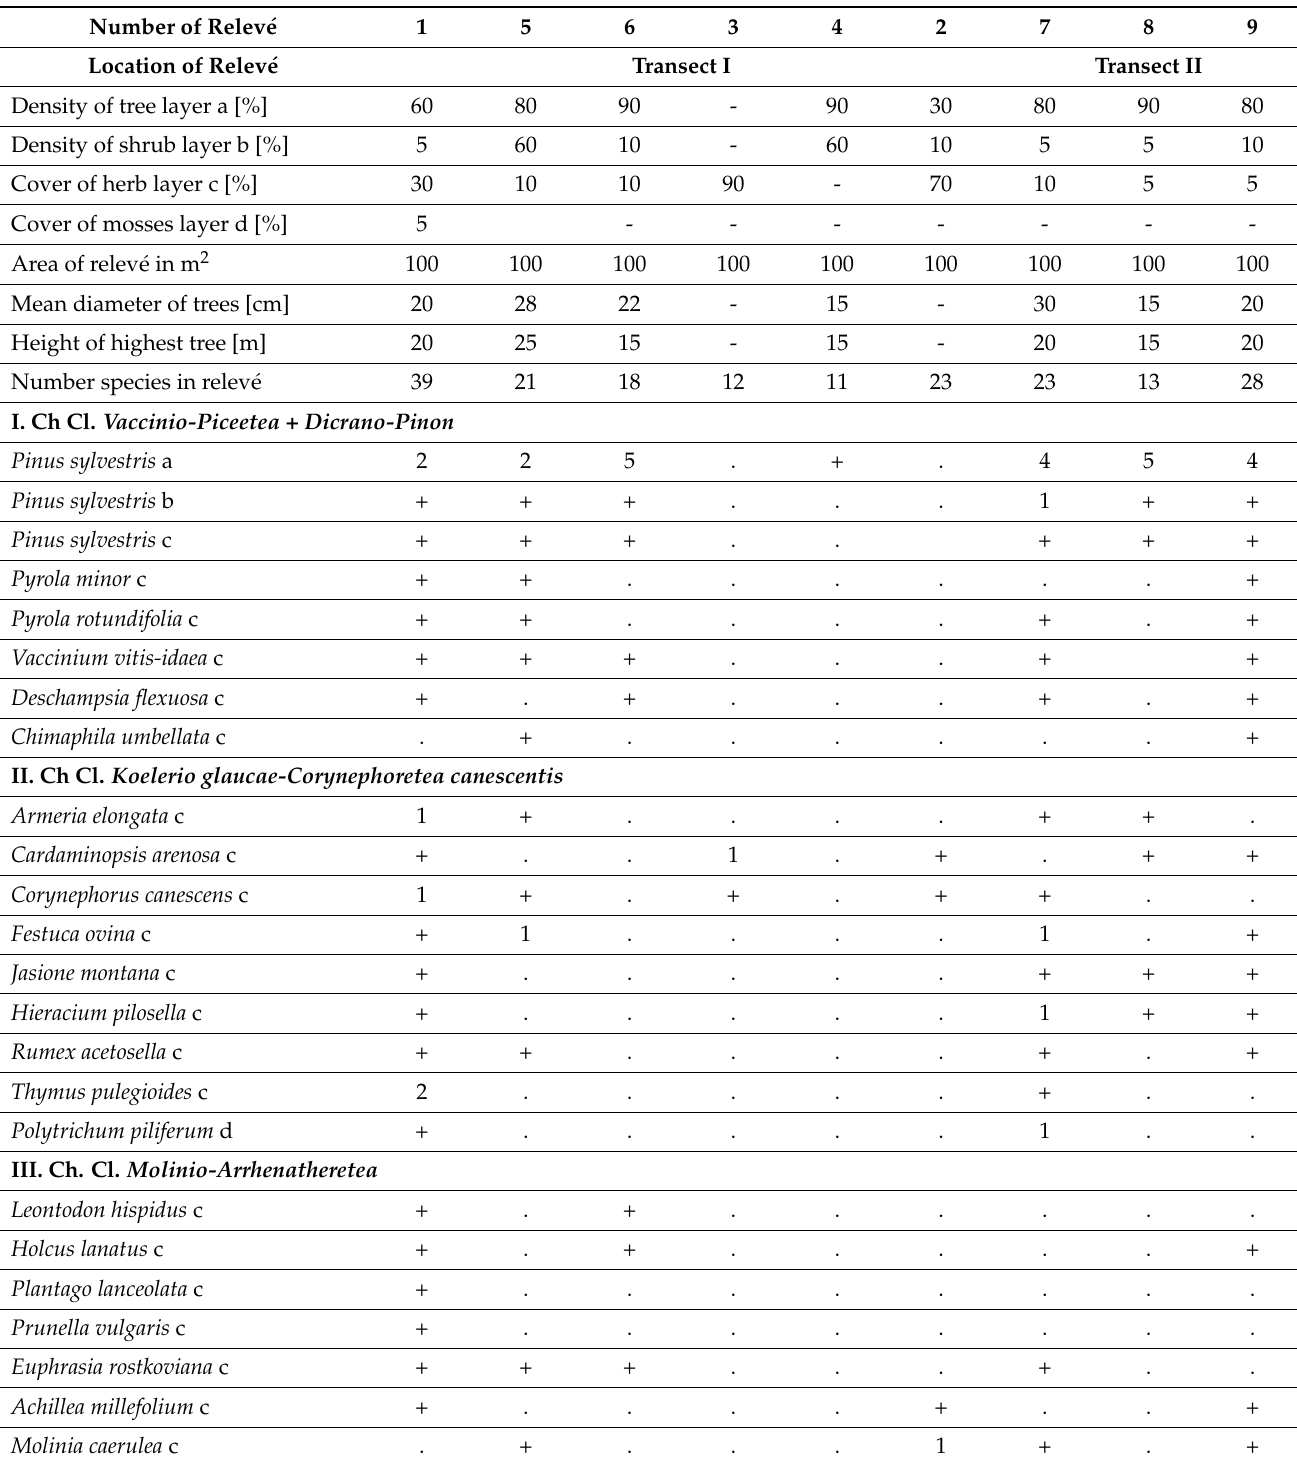
Table 1. The floristic composition of vegetation of the artificial mixed